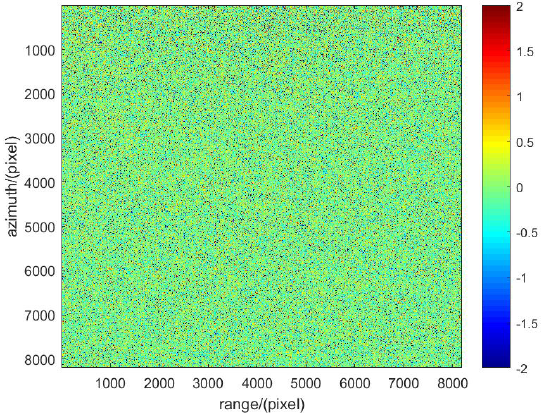
Figure 19. The extracted interferometric phase from the Gaofen-3 along-track InSAR data (size: 8192(azimuth)*8192(range)).